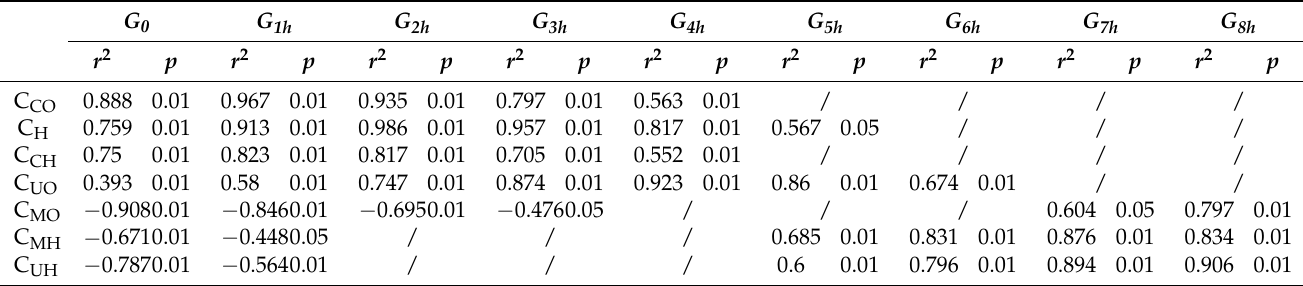
Table 4. Correlations between summertime net radiation and soil heat flux at different lagged conditions for all riparian